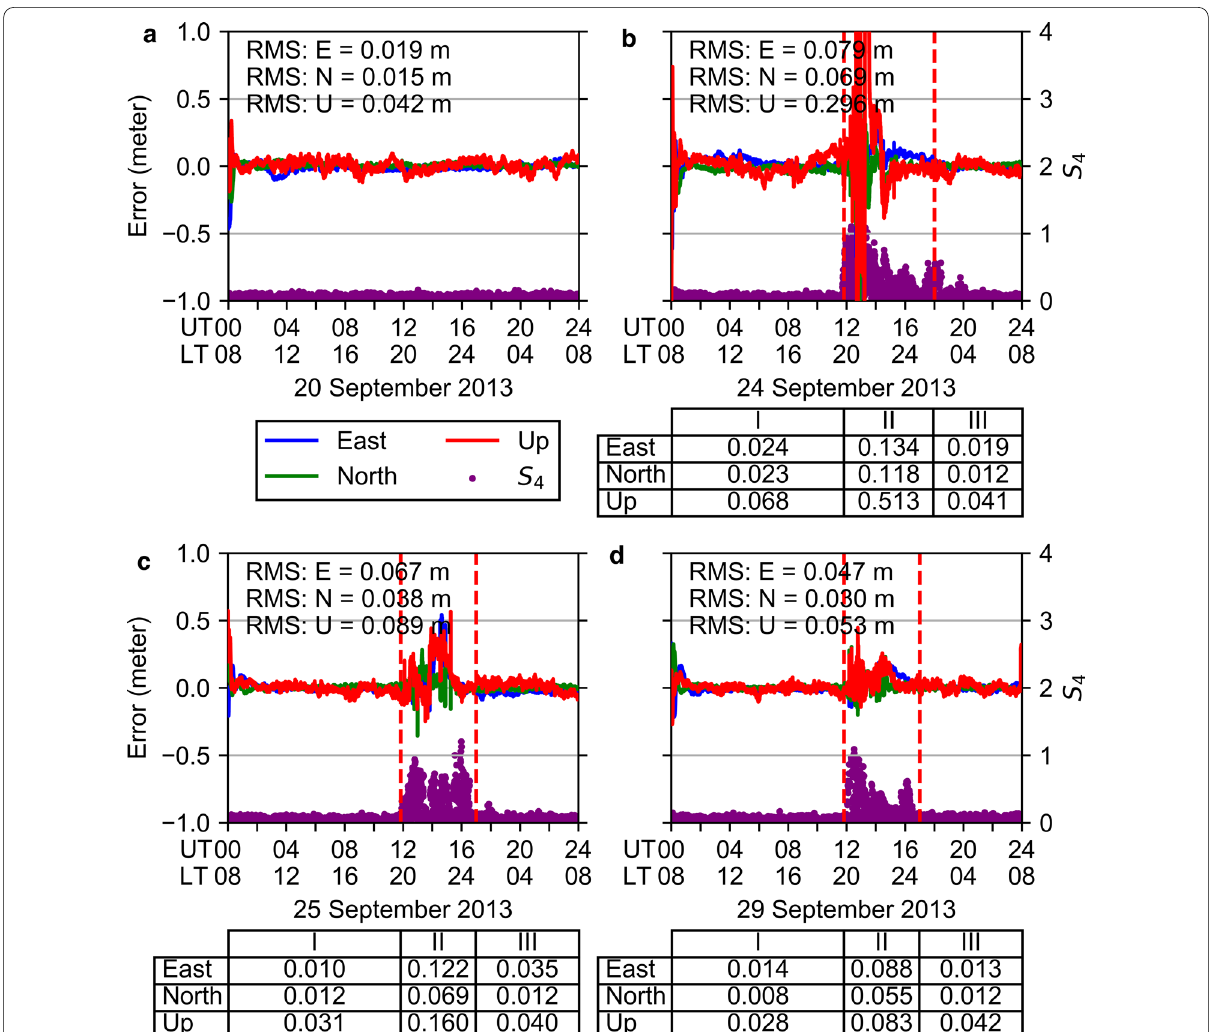
Fig. 15 Baseline solution of HKPC–HKOH in the components of east, north, and up along with ionospheric scintillation index on four typical days: 20 September 2013 without scintillations as shown in a , 24 September, 25 September, and 29 September with strong scintillations as shown in b – d . The RMS of the positioning errors during different periods separated by the vertical dashed lines is presented in the